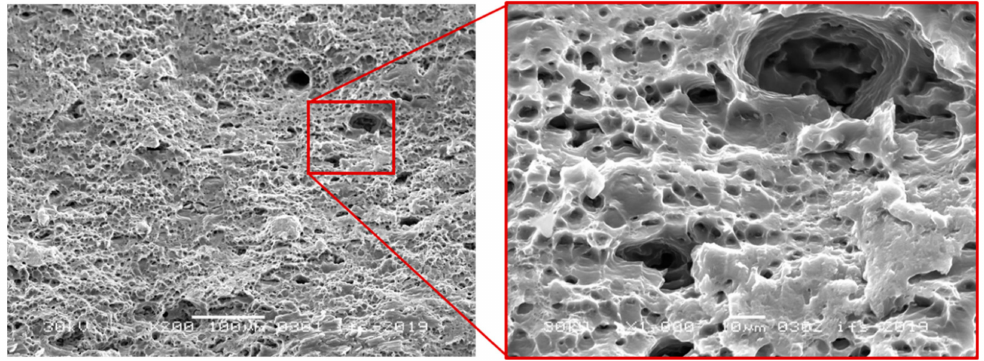
Figure 8. Scanning electron microscope microstructure of the fracture sample after the tensile